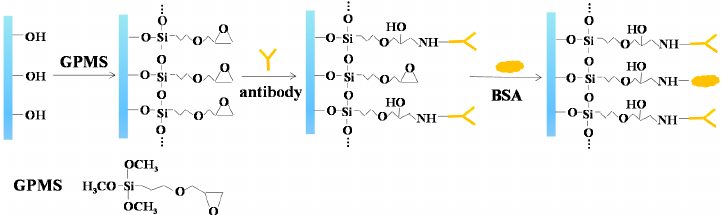
Figure 1. Scheme for surface modification of nanoporous alumina membrane by (3-glycidoxypropyl) trimethoxysilane (GPMS) and conjugation with anti-histamine antibody.